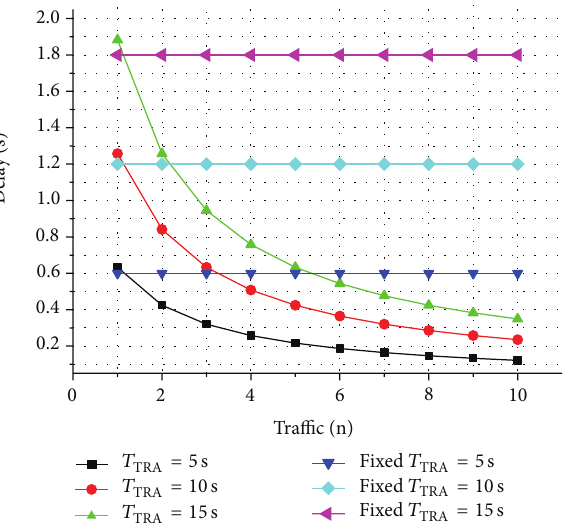
Figure 5: Response delay in uniform